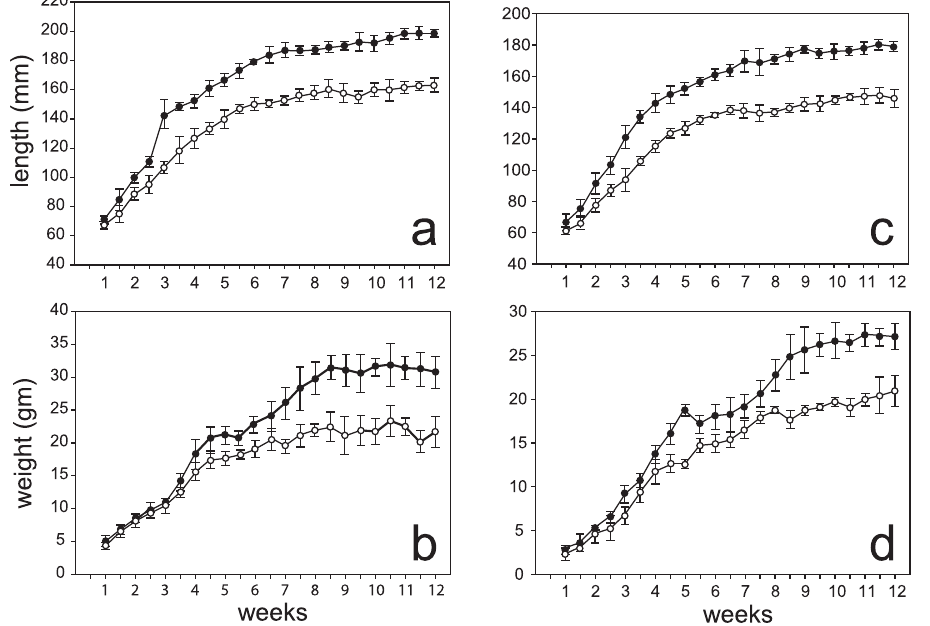
N Figure 2. Growth defects in MAPK14 loxp/loxp ;Col2a1-cre mice. Mean nose-to-tail lengths and body weights 6 SD for male (A,B) and female (C,D) ), MAPK14 loxp/loxp ;Col2a1-cre ( # ), n=19 for mutants, 20 for controls. mice from 1 to 12 weeks after birth, MAPK14 loxp/loxp (